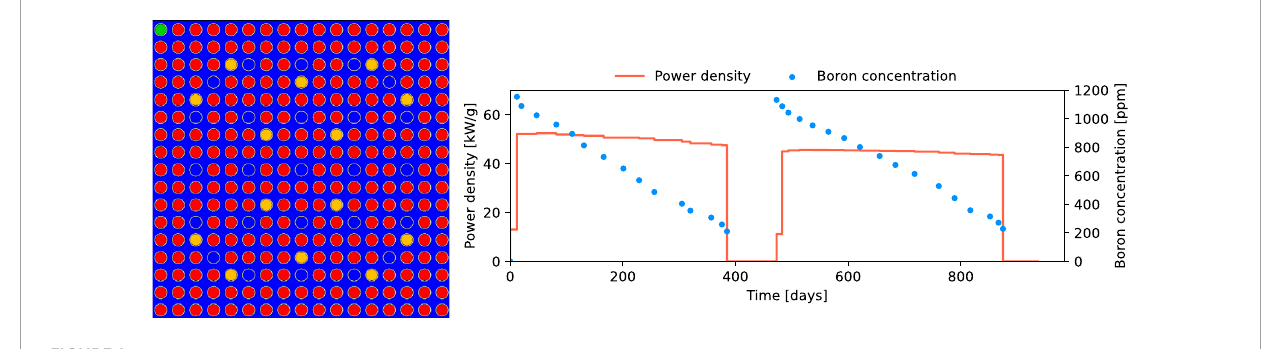
FIGURE 1 Two-dimensional lattice of the assembly NT3G23 Takahama SF95-4 (left) and sample power density and boron concentration time evolution